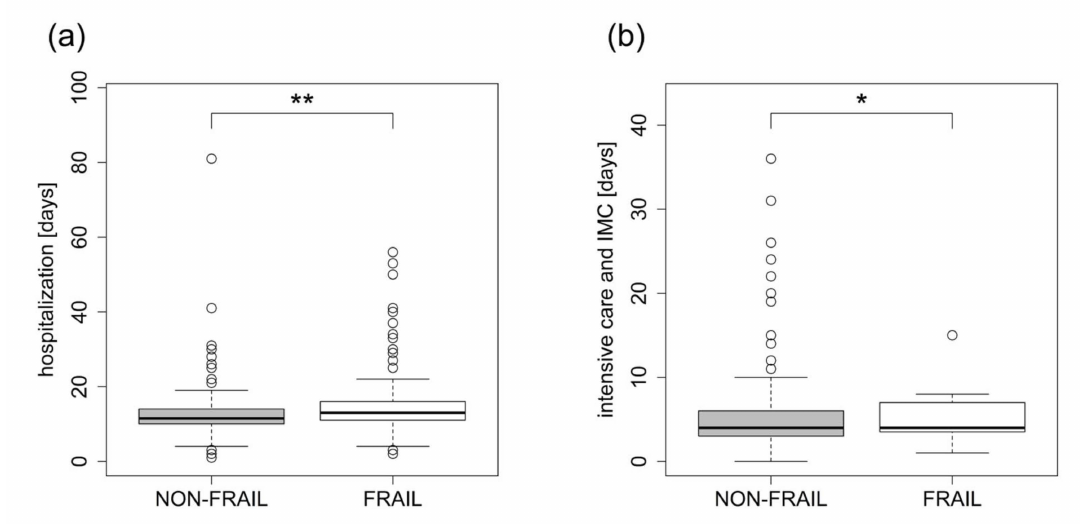
Figure 1. ( a , b ) Hospitalization and ICU/IMC stay. In-hospital stay: FRAIL 15.53 ± 8.5 days vs. NON- FRAIL 13.71 ± 8.94 days, p = 0.004, and duration of intensive care treatment including intermediate care: FRAIL 5.4 ± 4.33 days vs. 4.86 ± 4.78 days NON-FRAIL, p = 0.014. IMC = intermediate care, * p < 0.05, ** p < 0.01.